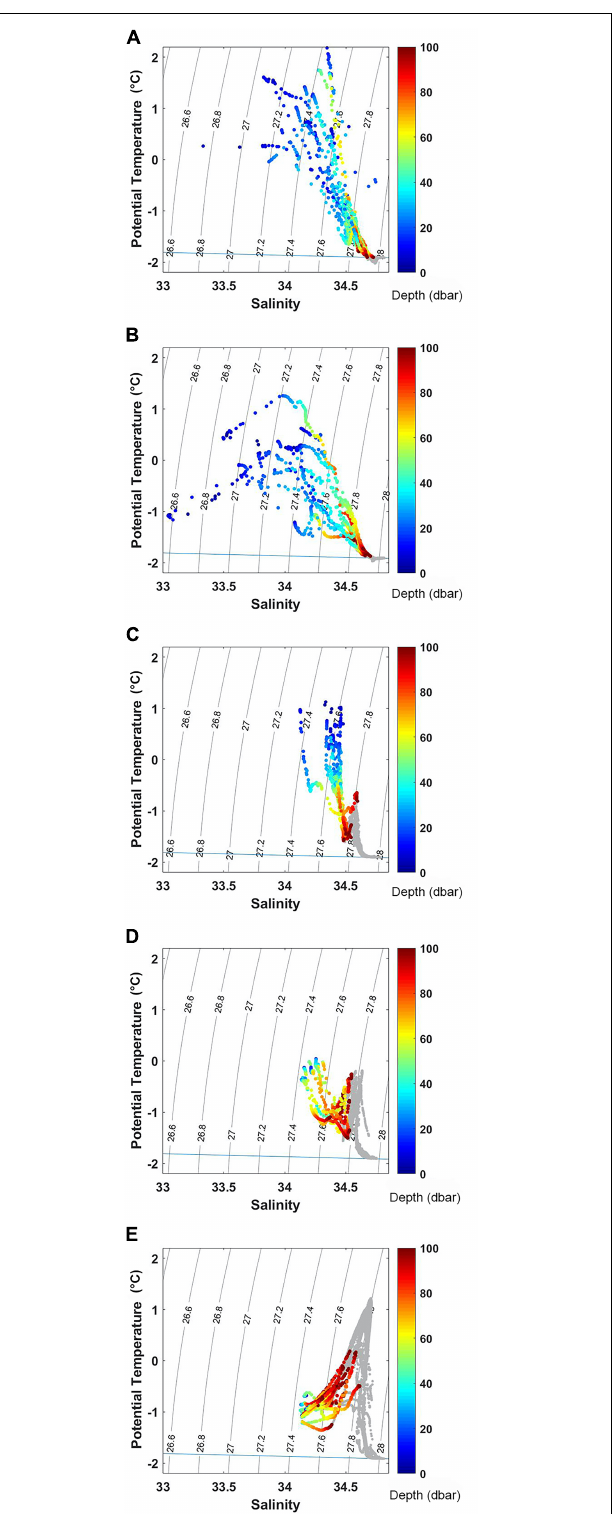
FIGURE 2 | (cid:50) /S diagram for each sub-system: Area 1 (A) , Area 2 (B) , Area 3a (C) , Area 3b (D) , Area 4 (E) . The color bar indicates the first 100 m depth, deeper layers are reported in